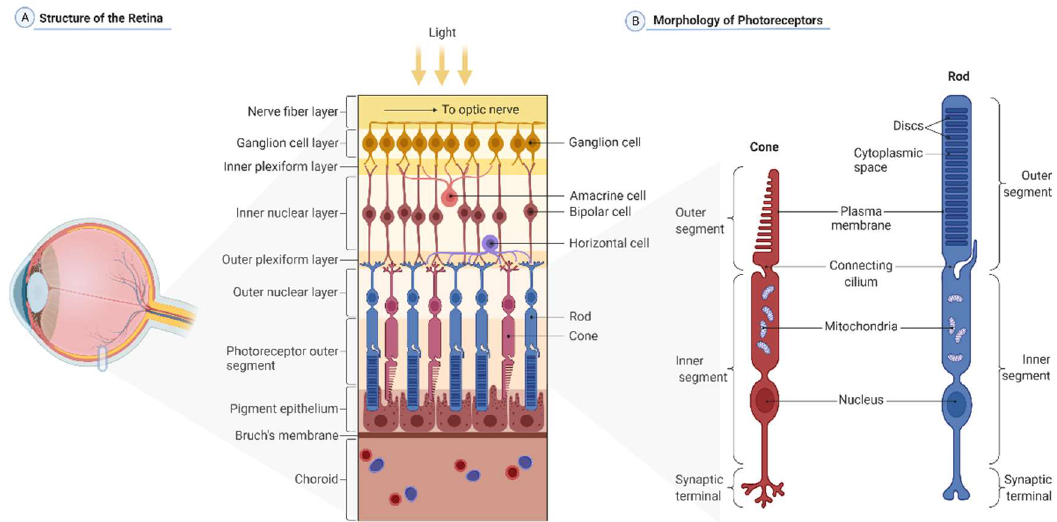
Figure 1. ( A ) Cellular organization of the retina. The retina contains the retinal neuronal cell types, such as the retinal pigment epithelium (RPE), which faces choroidal blood vessels at the basal side, and cones (purple) and rods (blue) at the apical side. The photoreceptor nuclei constitute a layer called the outer nuclear layer (ONL), whereas their axons and processes meet with horizontal (violet) and bipolar (red) cells in the outer plexiform layer (OPL). More anterior, the inner nuclear layer (INL) harbors nuclei of the bipolar (red), amacrine (pink), and horizontal (violet) cells, and Müller glia, while the inner plexiform layer (IPL) contains the processes and synapses of bipolar (red) cells, amacrine (pink) cells, and retinal ganglion cells or RGCs that are reduced in number by the stage of photoreceptor maturation (yellow). ( B ) Structure of rod and cone photoreceptors. Photoreceptors are polarized sensory neurons. Rods (blue) and cones (red) have three cellular compartments. Outer segments (OS) are stacks of membrane disks rich in the visual pigment rhodopsin. This is where phototransduction originates. Interestingly, this cellular part does not contain any protein synthesis machinery. All OS proteins are synthesized in the inner segments (IS) and then transported to this cellular part. IS also contain other vital organelles, i.e., mitochondria, and the nucleus. Neuronal impulses created in the OS pass through the IS until they reach the synaptic terminals, where they are transmitted to other retinal neurons. (Created with BioRender.com).